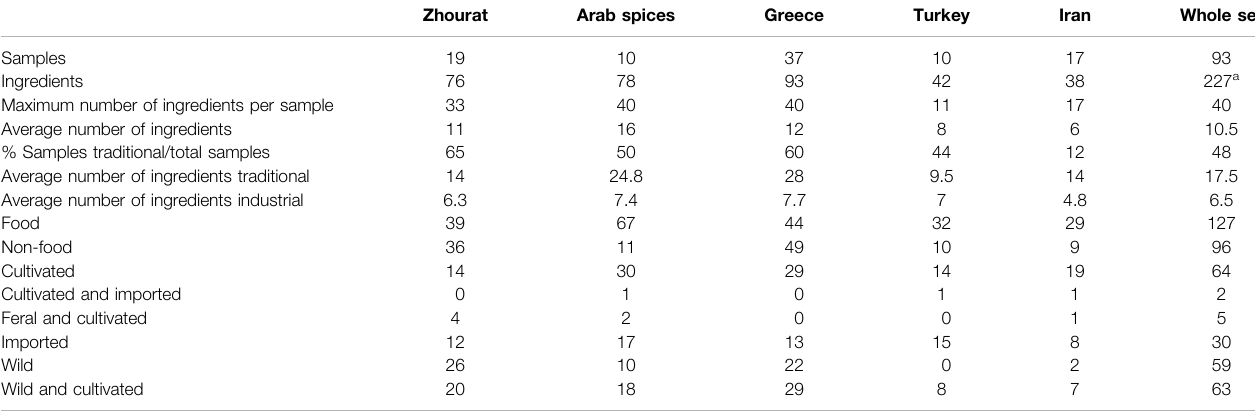
TABLE 1 | Types and frequencies of plant-based ingredients.